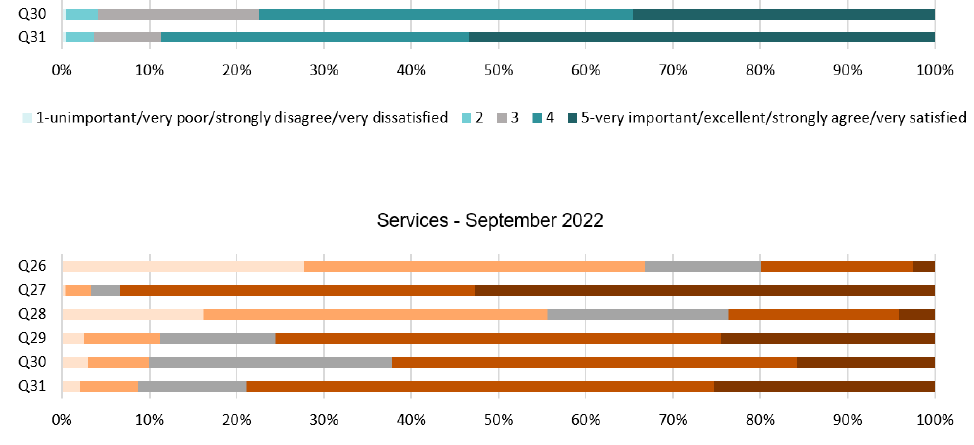
Figure 12. Services dimension chart.